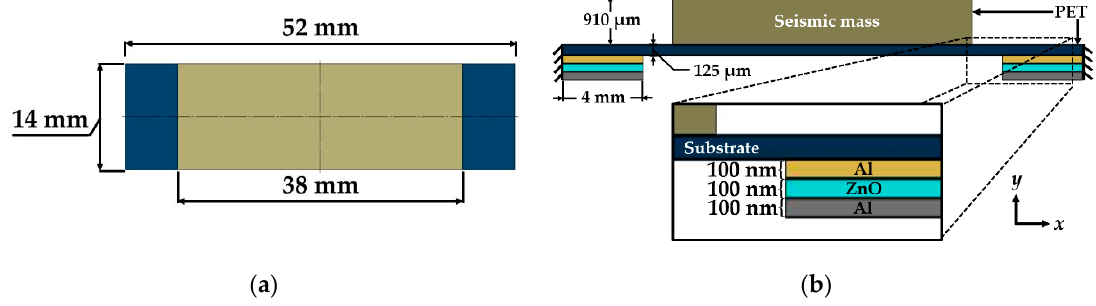
Figure 2. ( a ) Top view and ( b ) front side view (not to scale) of the different layers of the piezoelectric nanogenerator.